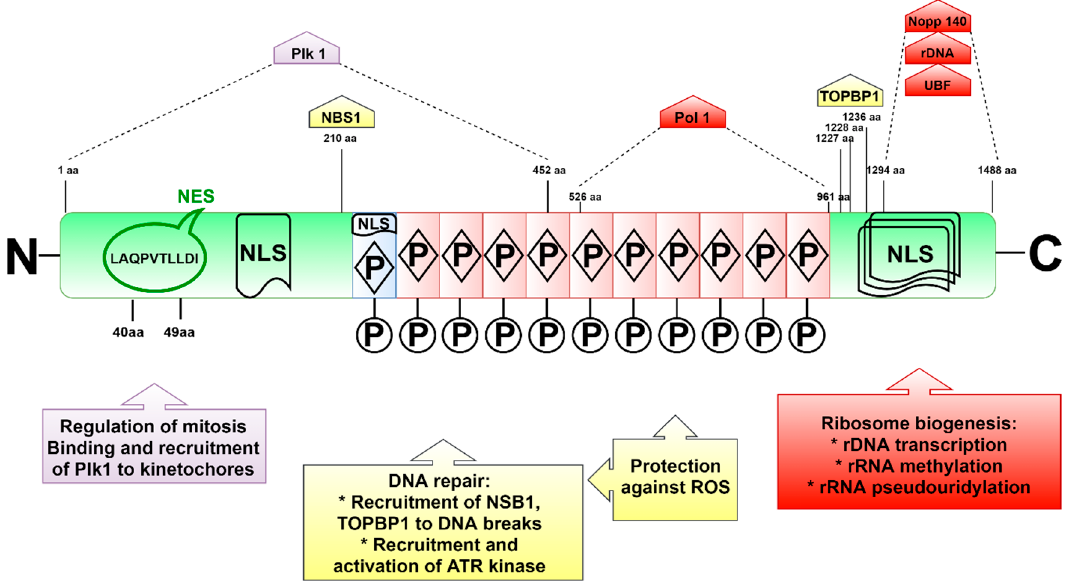
Figure 7. The summary of the key treacle functions in the cell. The molecules interacting with specific amino acids of Table 140. and UBF. In response to DNA damage, treacle binds and recruits NBS1 to the nucleolus, enabling silencing of rRNA transcription. Interaction with TOPBP1 enables recruitment and activation of ATR kinase, a crucial regulator of DNA damage response. Treacle function in the antioxidative defense is tightly linked with its role in DNA damage repair. The ability of treacle to regulate mitosis and cell cycle progression relies on its interaction with Plk1.